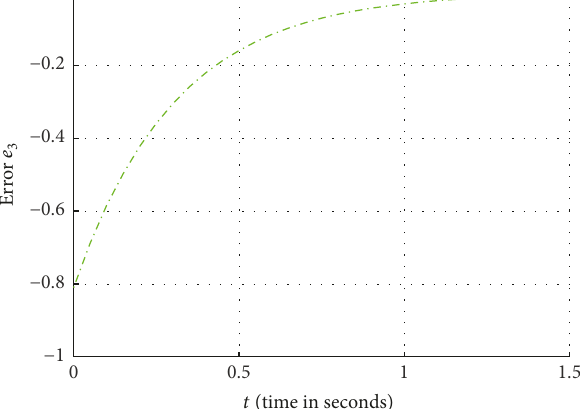
(34) and slave system (36) is achieved and the error